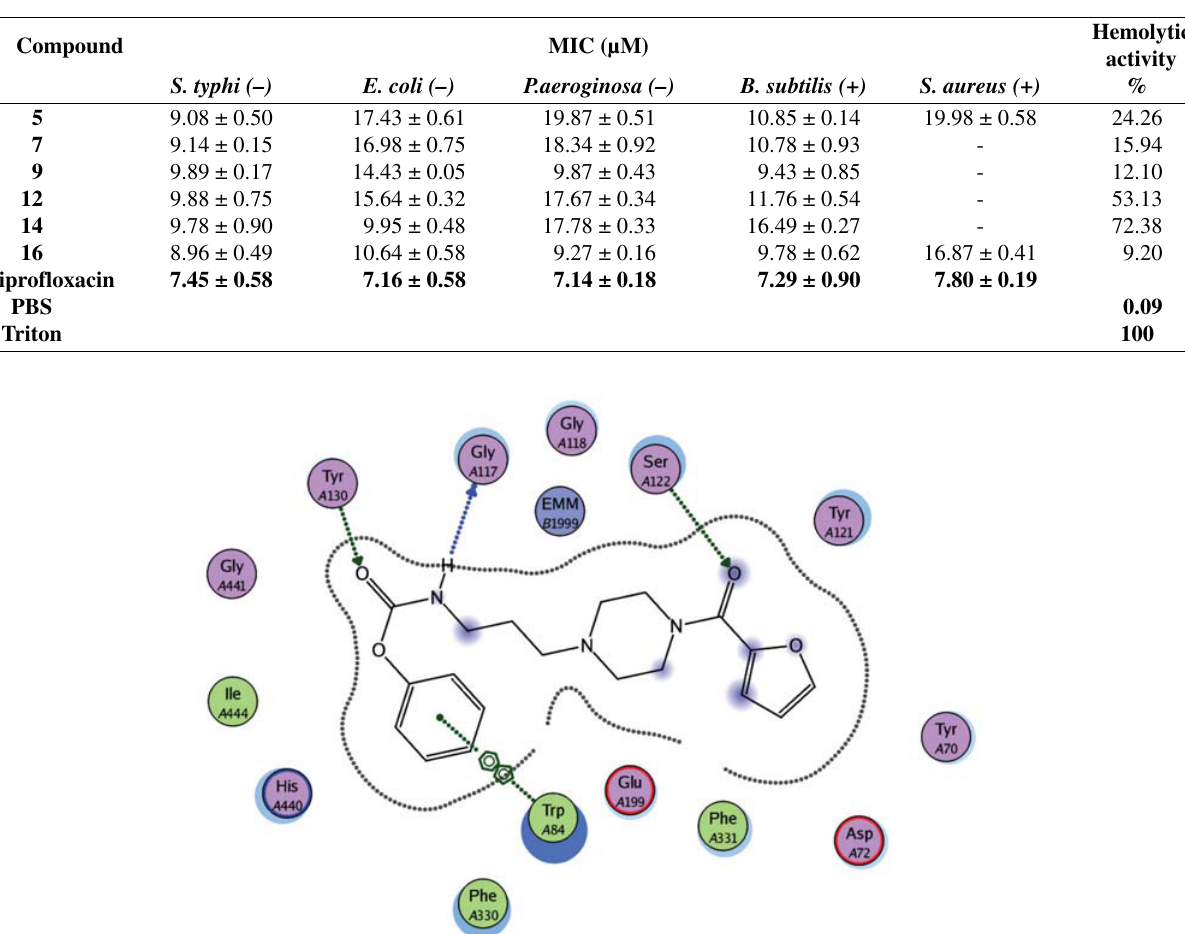
Fig. 4. 2D interacted image of phenyl 3- [ 4-(2-furoyl)-1-piperazinyl ] propylcarbamate ( 12 ) against acetylcholinestrase.